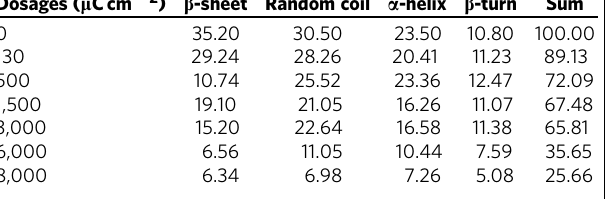
Table 1 | Quantification of the nanoIR spectra using deconvolution (Percentage: %).